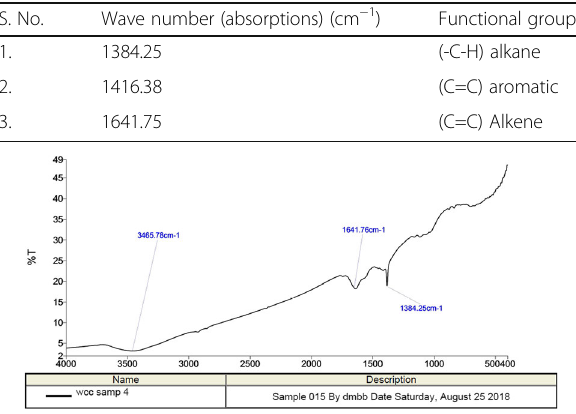
Table 1 FT-IR analysis A. muricata peel S. No.